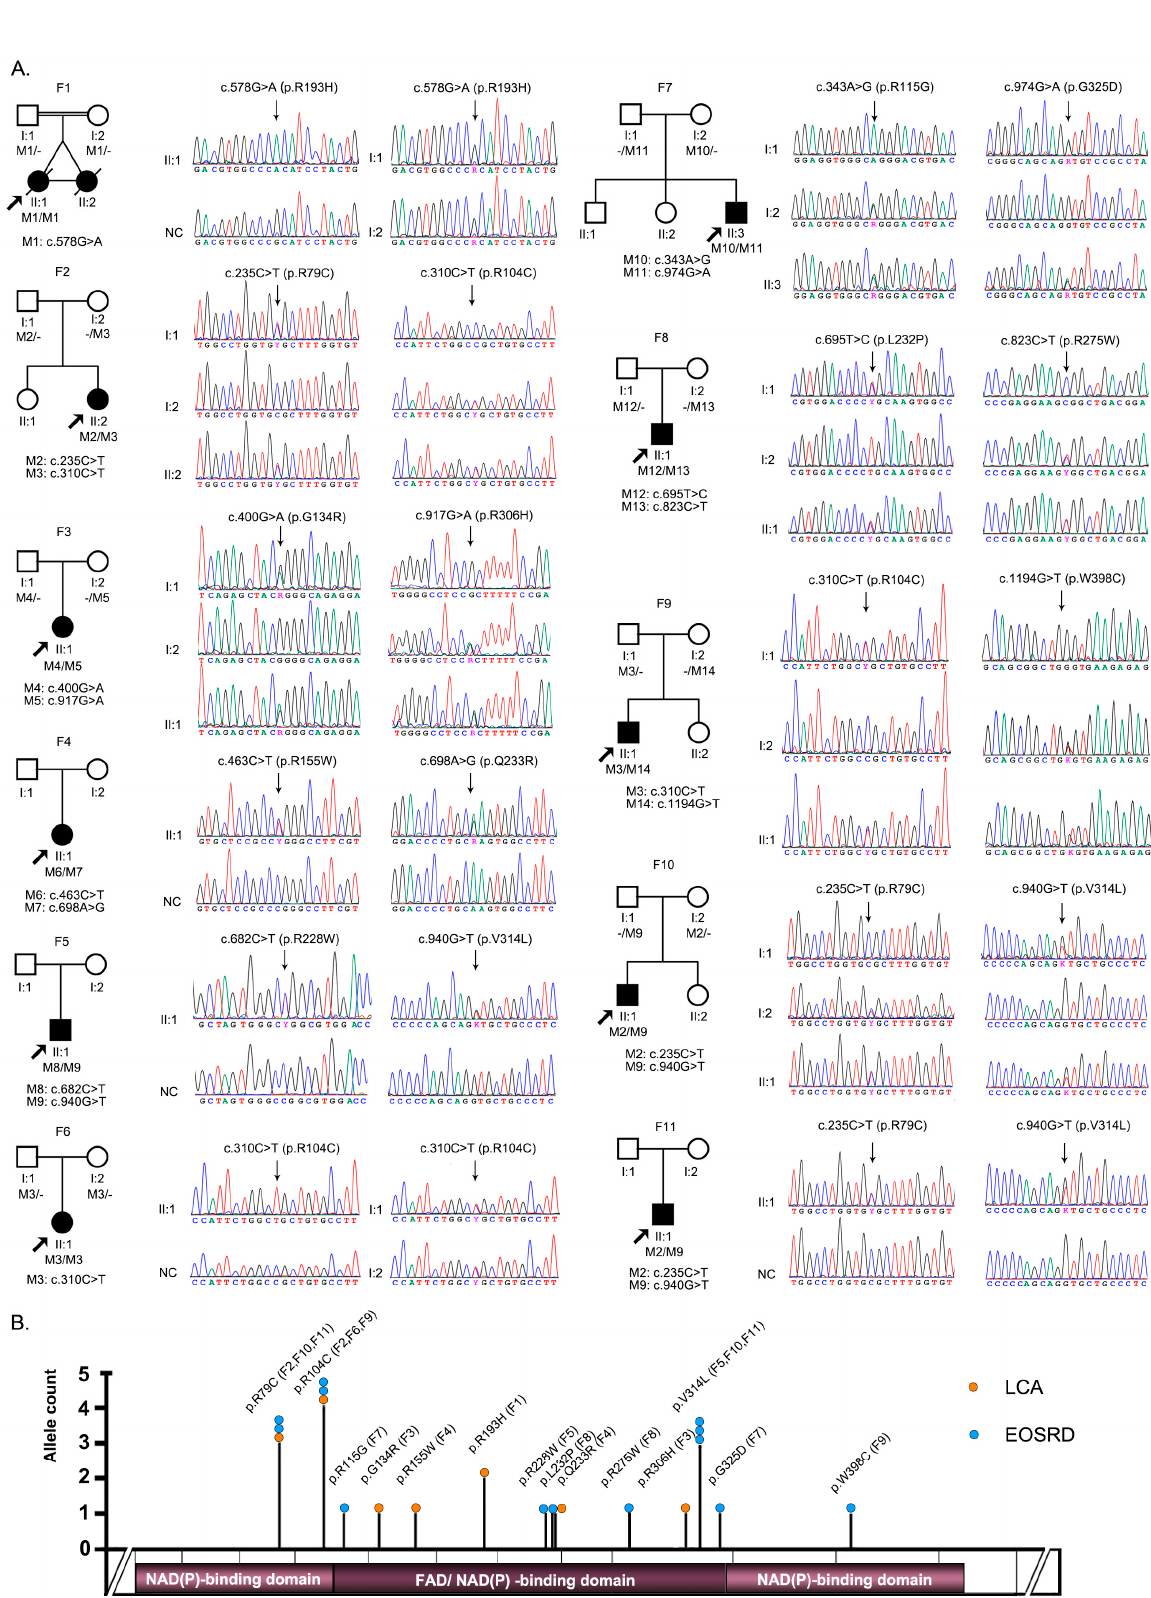
Figure 1. ( A ) Pedigree diagrams and Sanger sequencing of the 11 families with biallelic pathogenic or likely pathogenic FDXR variants. ( B ) Schematic diagram of FDXR and its variants. EOSRD, early-onset severe retinal dystrophy; LCA, Leber congenital amaurosis; NC, normal